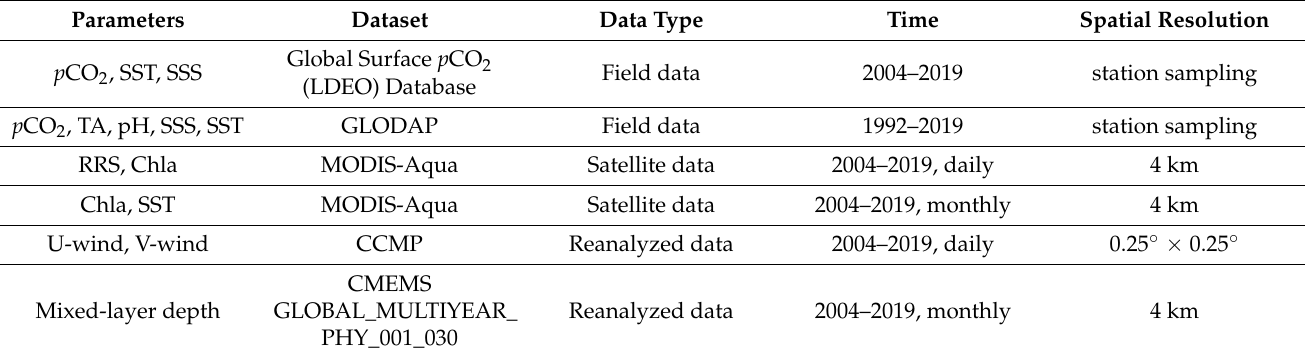
Table 1. Summary information of field measurements and remote sensing data used in this